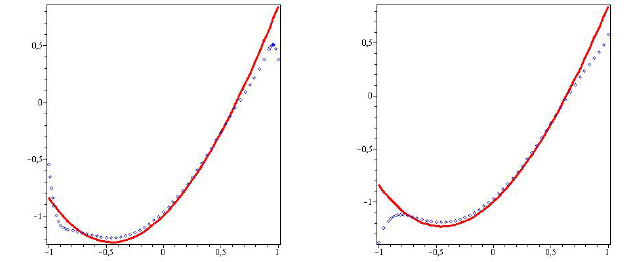
Figure 1. On the left: the plots of the function f (red line) and of the 2-layers NN operators D 2 f (blue dots) activated by the logistic function. On the right: the plots of (10 , 10) the function f (red line) and of the 3-layers NN operators D 3 f (blue dots) activated (10 , 10 , 10) by the logistic